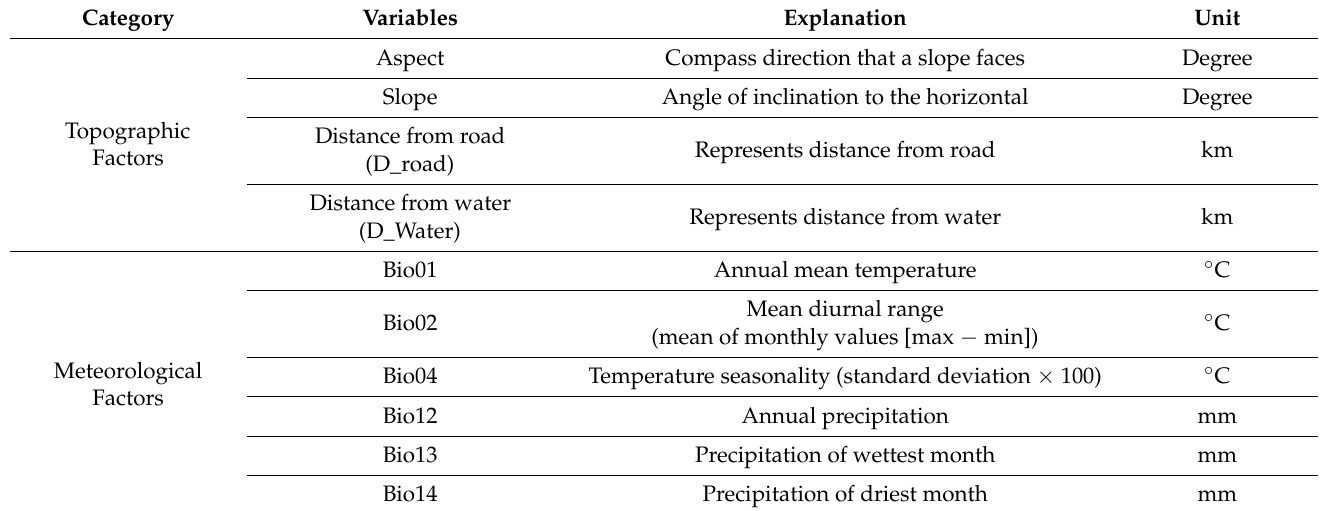
Table 2. Environmental variables used for the prediction of suitable